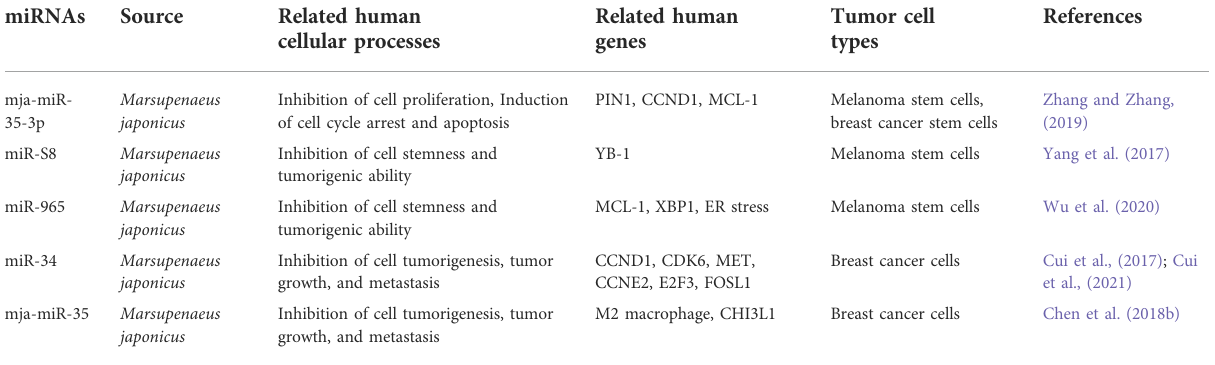
TABLE 4 Marine food-derived miRNAs as anti-tumor